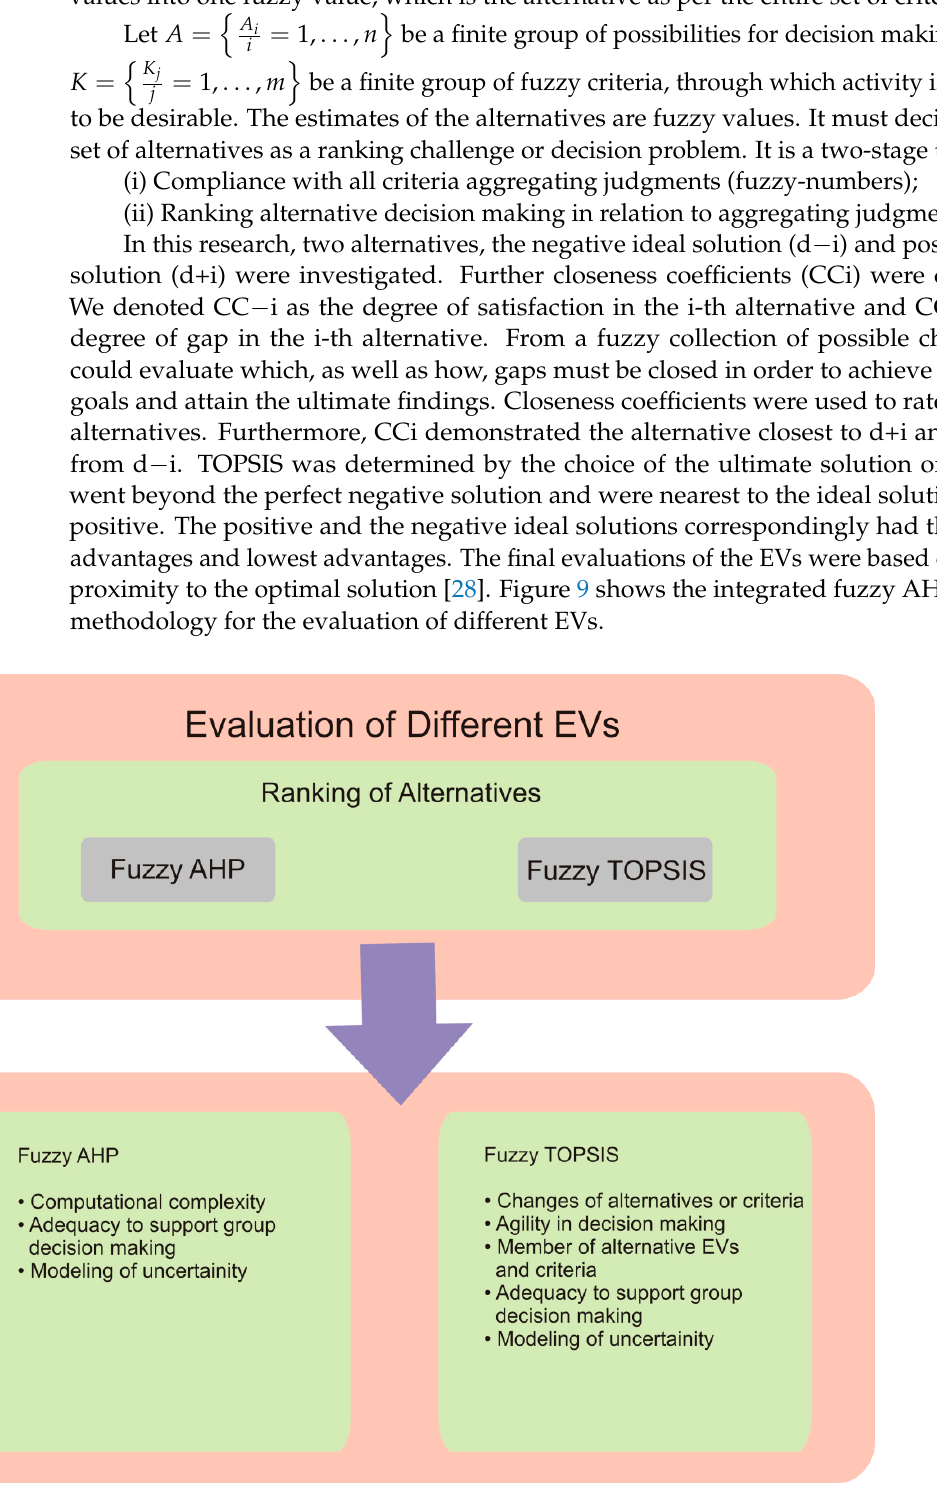
Figure 9. The fuzzy AHP TOPSIS methodology for the evaluation of different EVs.